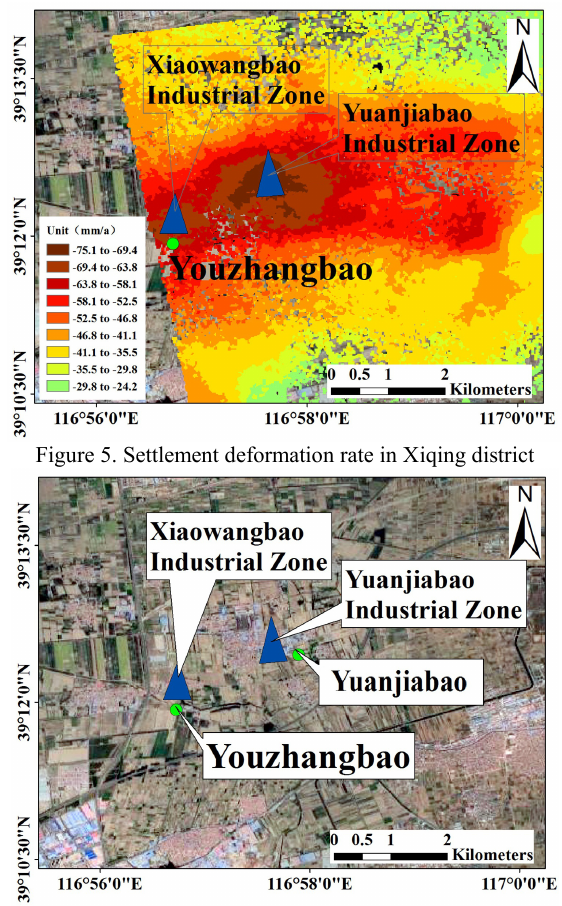
Figure 6. Surface space utilization in Xiqing